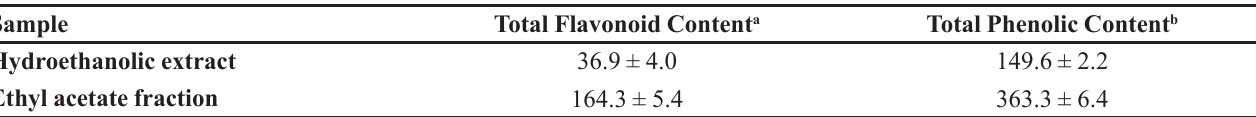
TABLE I - Total flavonoid and phenolic compound content in the hydroethanolic extract and the ethyl acetate fraction from Kalanchoe pinnata leaves. The data shown as the mean ± S.E.M. ;